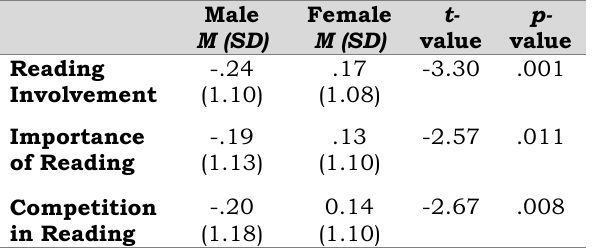
Table 2. Independent Sample t -test Result of Reading Motivation by